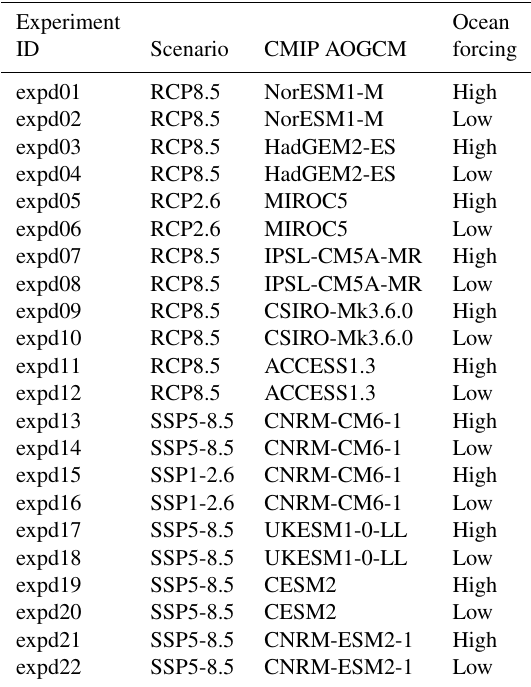
Table A7. Description of ISMIP6 Greenland Tier 3 simulations to investigate impact of ocean